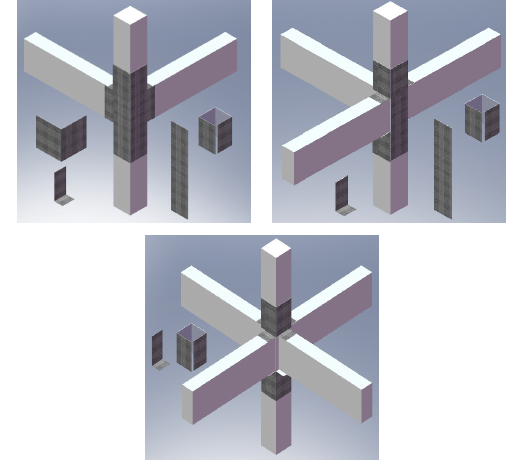
Fig. 4. Defining material properties on joints. Figure 4. Defining Material Properties on Joints